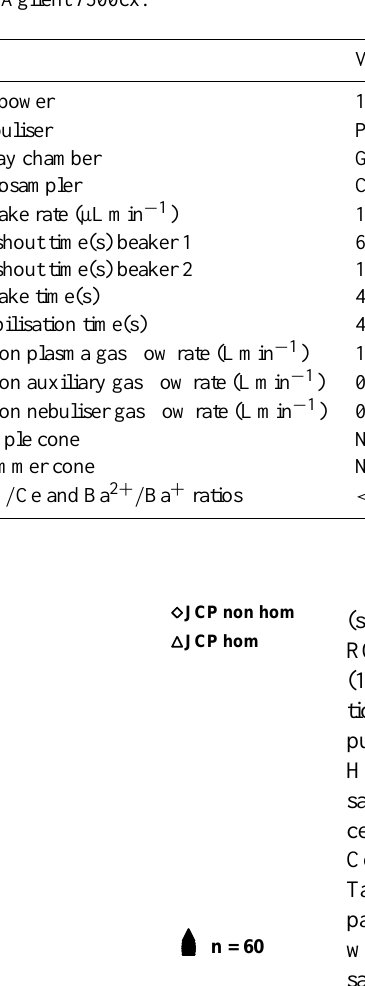
Table 3. Operation conditions for Agilent 7500cx.